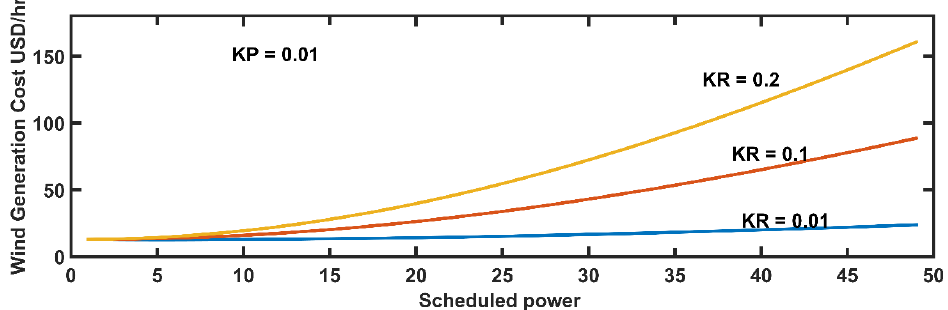
Figure 15. Wind generation cost versus scheduled power with changes of K R .